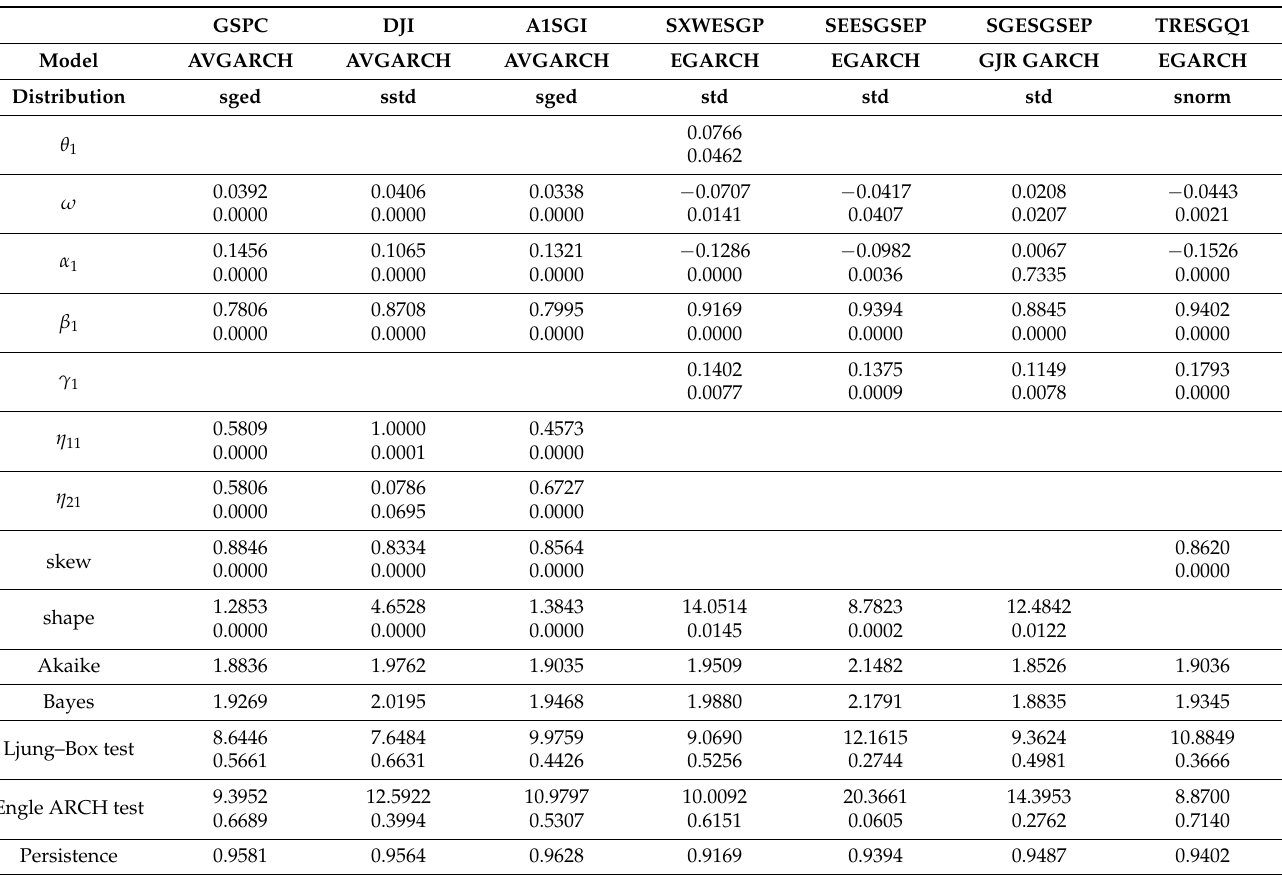
Table A5. Family ARMA-GARCH models, 4 January 2017–31 December